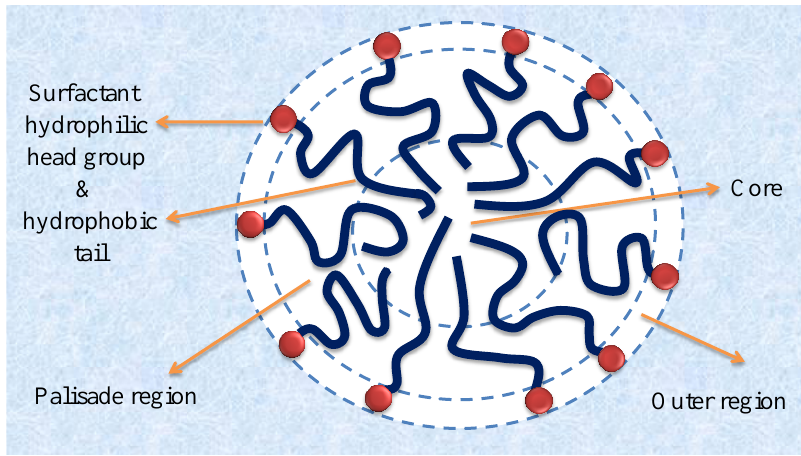
Figure 4. A surfactant micelle in water. Three different regions can be identified: the outer region, the palisade region and the